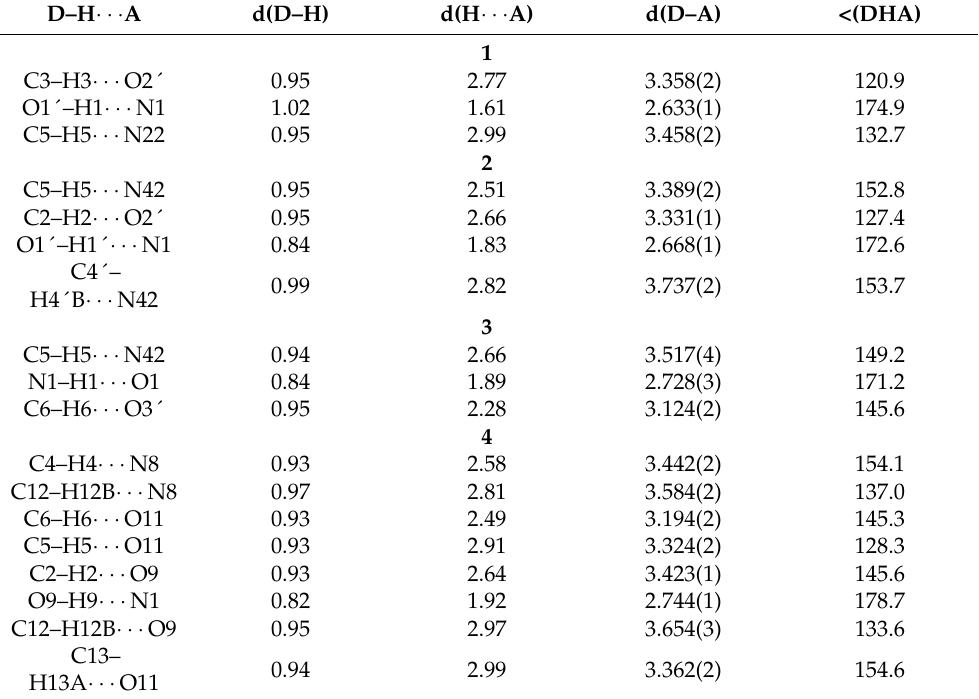
Table 5. Selected parameters for hydrogen bonding interactions in 1 – 4 .